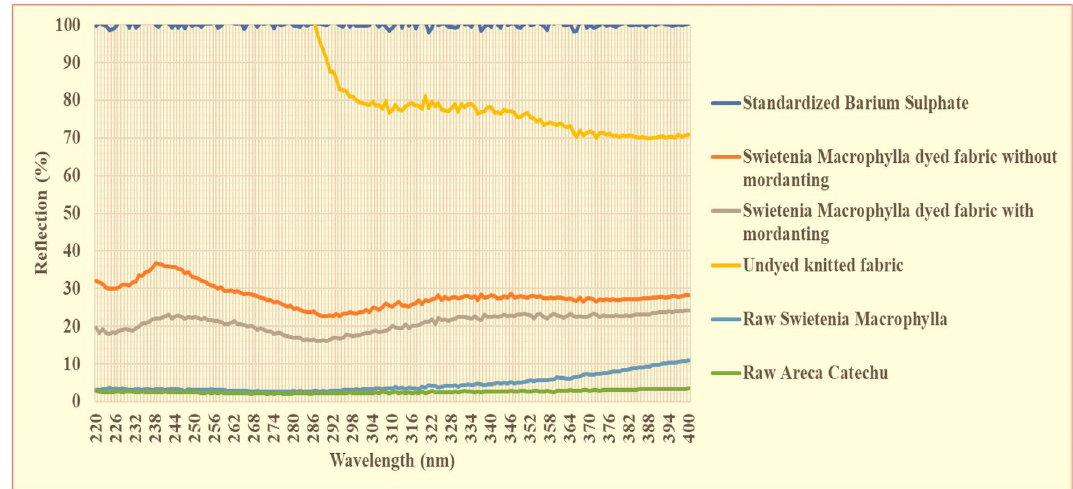
Figure 6. UV-reflection of Swietenia Macrophylla dyed fabric with NPND mordanting and without mordanting, untreated cotton fabric, raw Swietenia Macrophylla and raw Areca Catechu compared with standardized barium